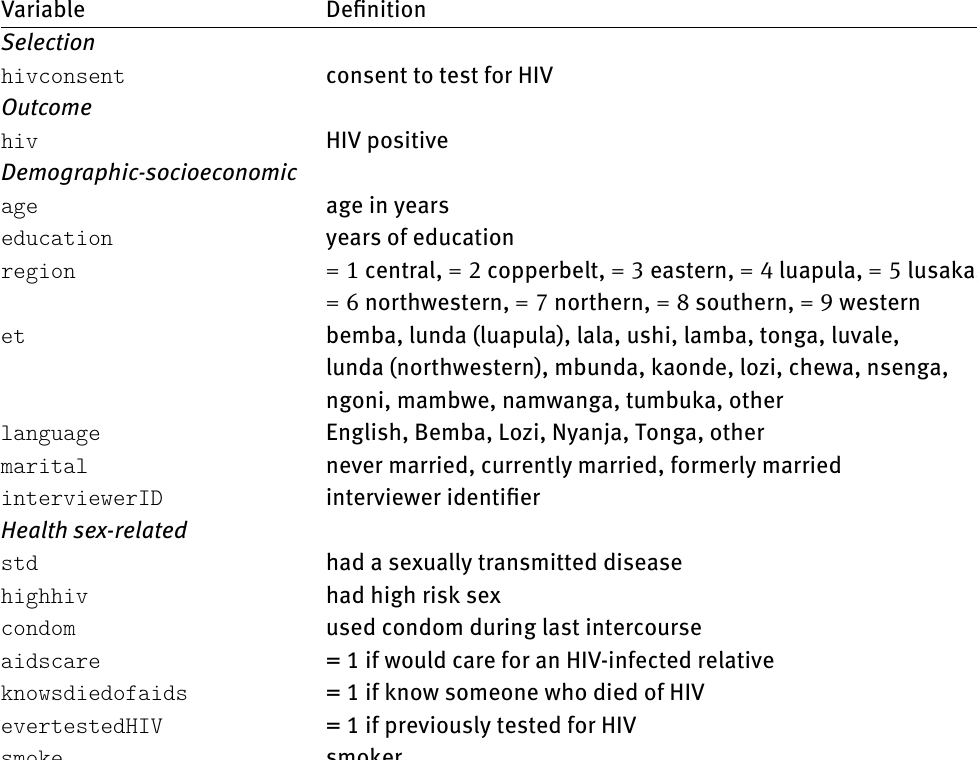
Table 2: HIV data: description of the outcome and selection variables, and observed confounders.